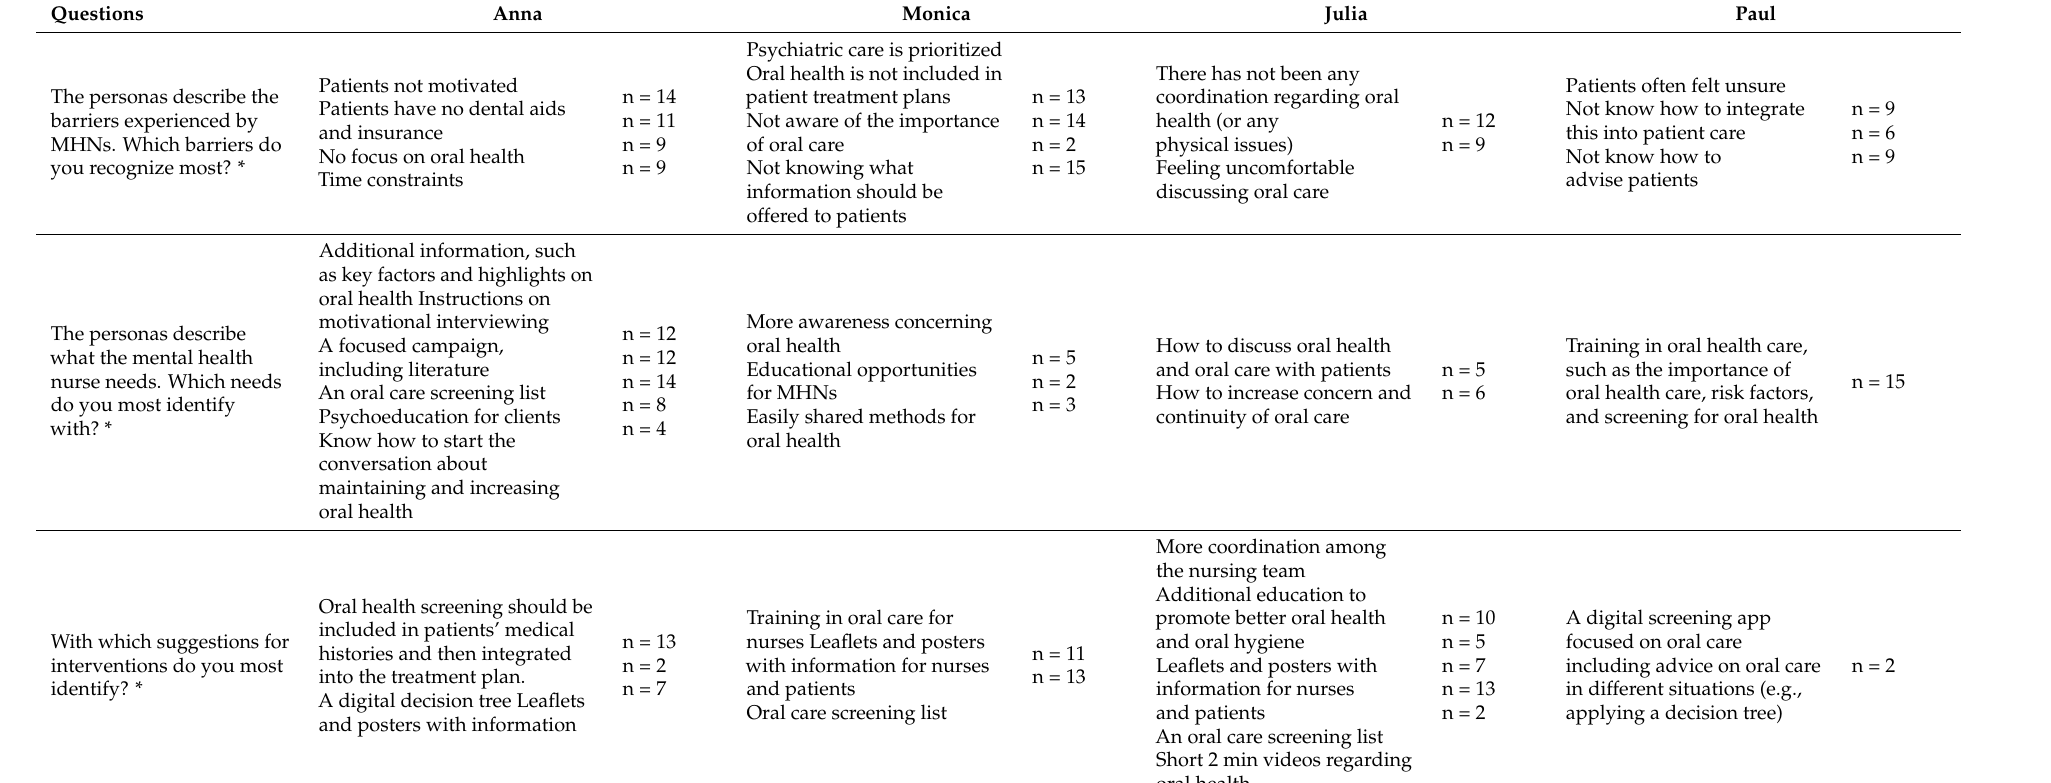
Table A3. Prevalence of Answers on Elements of Personas Given by